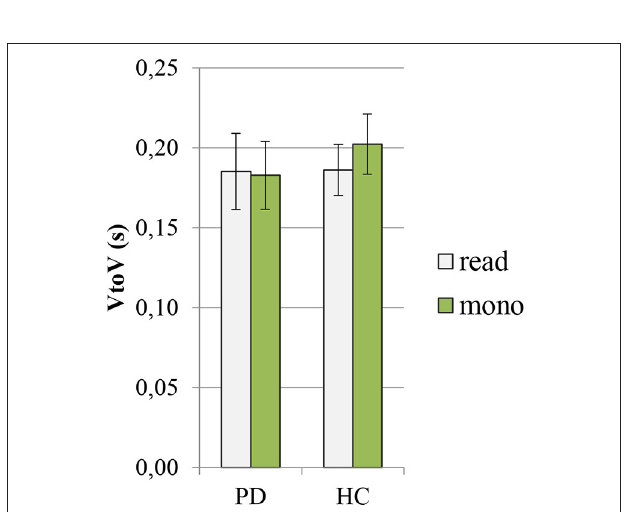
FIGURE 5 | Mean values of VtoV (s) in PD and HC productions (read: reading task; mono: monolog). PD, Parkinson’s disease; HC, healthy control.